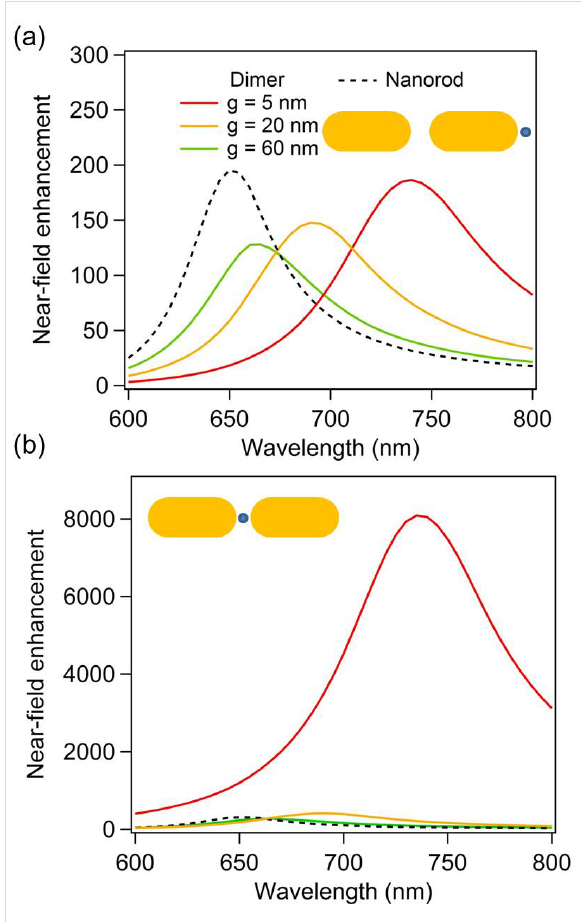
Figure 2: (a) Enhancement of the fundamental intensity evaluated at the nanorod extremities (2.5 nm away from the surface) as a function of the wavelength for nanodimers with gaps g = 5 nm, 20 nm, and 60 nm as well as for a single nanorod. (b) Enhancement of the funda- mental intensity evaluated at the gap center as a function of the wave- length for nanodimers with gaps g = 5 nm, 20 nm, and 60 nm as well as for a single nanorod. The field enhancement is evaluated at 2.5 nm away from the nearest surface.